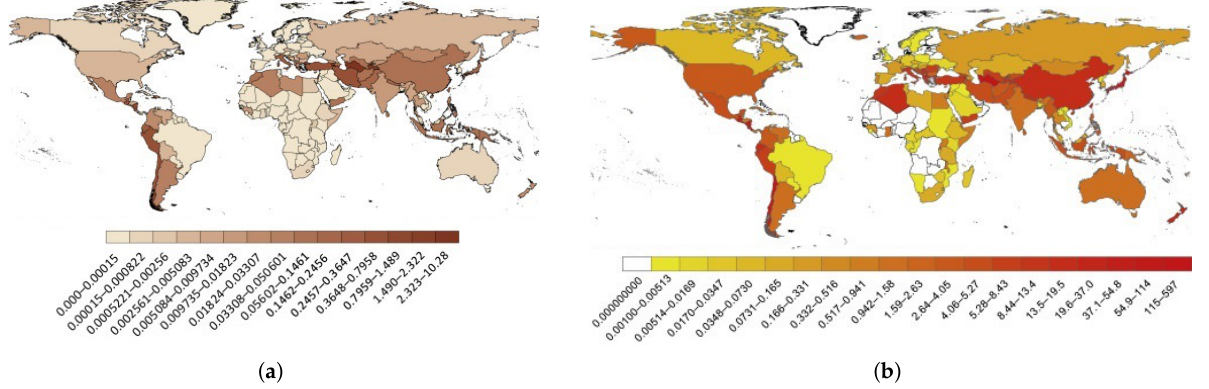
Figure 1. ( a ) Number of yearly earthquake fatalities cumulated in the period 1900 to 2012, split up by population; ( b ) economic loss (GDP) due to earthquakes accrued between 1900 and 2012 at the time of occurrence [11].